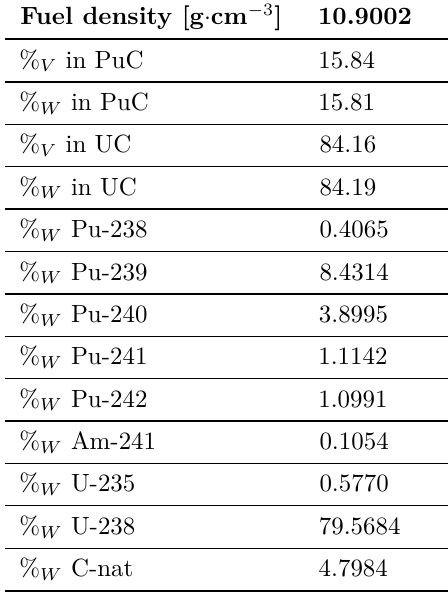
Table 3. Fuel material composition [15].